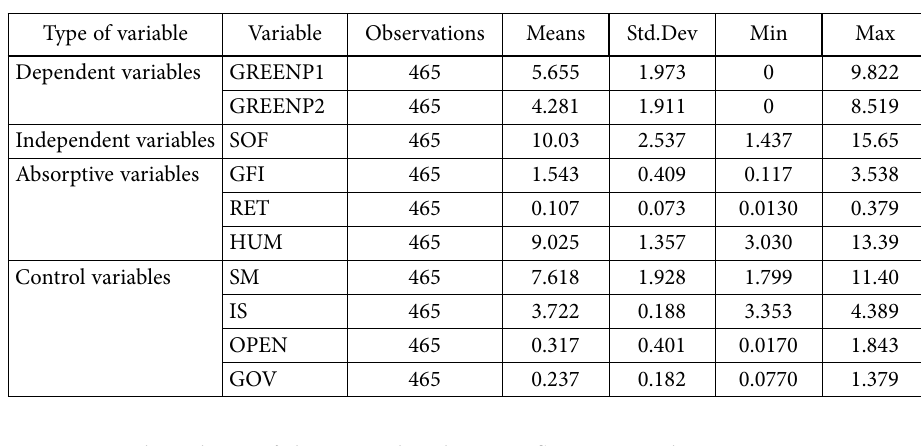
Table 1. Descriptive